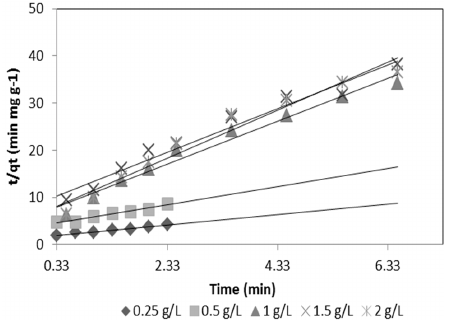
Figure 5. Kinetic sorption of As(V) for silica sand coated with Fe(III).